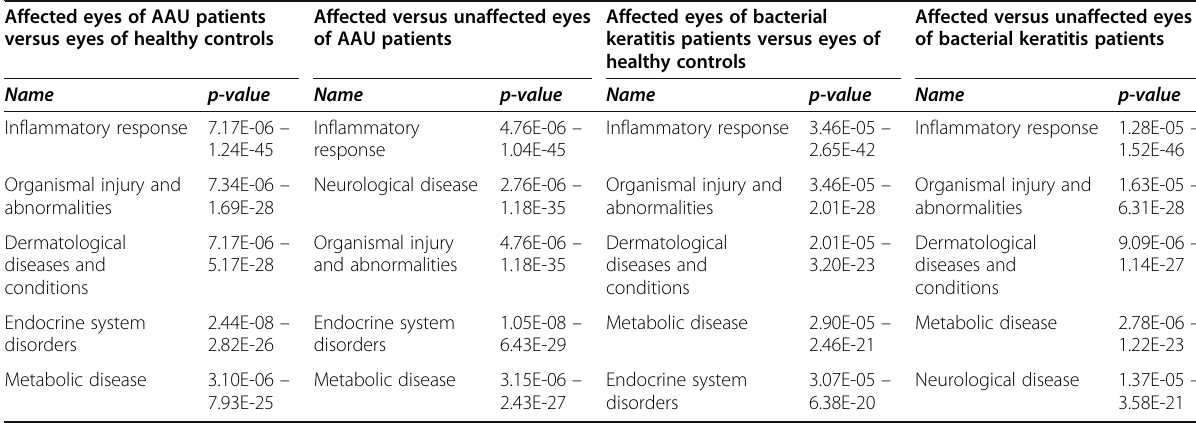
Table 5 Top diseases and bio functions - diseases and disorders Affected eyes of AAU patients versus eyes of healthy controls